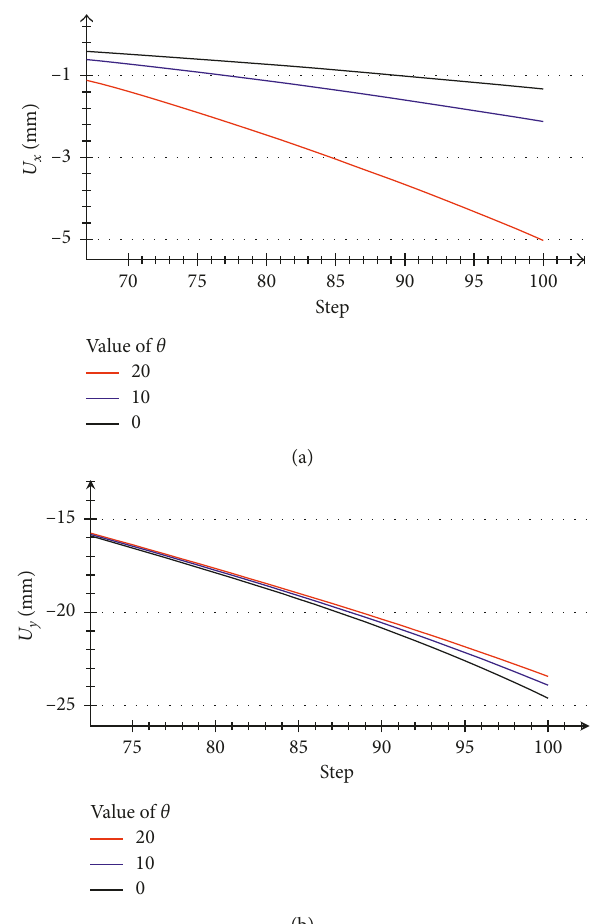
Figure 13: Displacements of the tunnel with different dilatancy angles: (a) vertical displacement U y at the top of the tunnel; (b) horizontal displacement U x at the bottom edge of the tunnel.